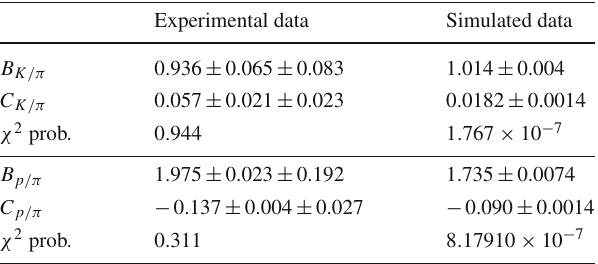
Table11 Valuesoftheparameters B K /π (Eq.(25))and C K /π (Eq.(26)) obtained fitting Eq. (23) to the experimental and simulated values of F h ( K )/ F h (π) as a function of E beam shown Fig. 23a. Values of the parameters B p /π (Eq.(27))and C p /π (Eq.(28))obtainedfittingEq.(24) to the experimental and simulated values of F h ( p )/ F h (π) as a function of E beam shown Fig. 23b. In the case of simulated (experimental) data results, statistical (statistical and systematic) uncertainties are reported. The fit χ 2 probability values are also shown